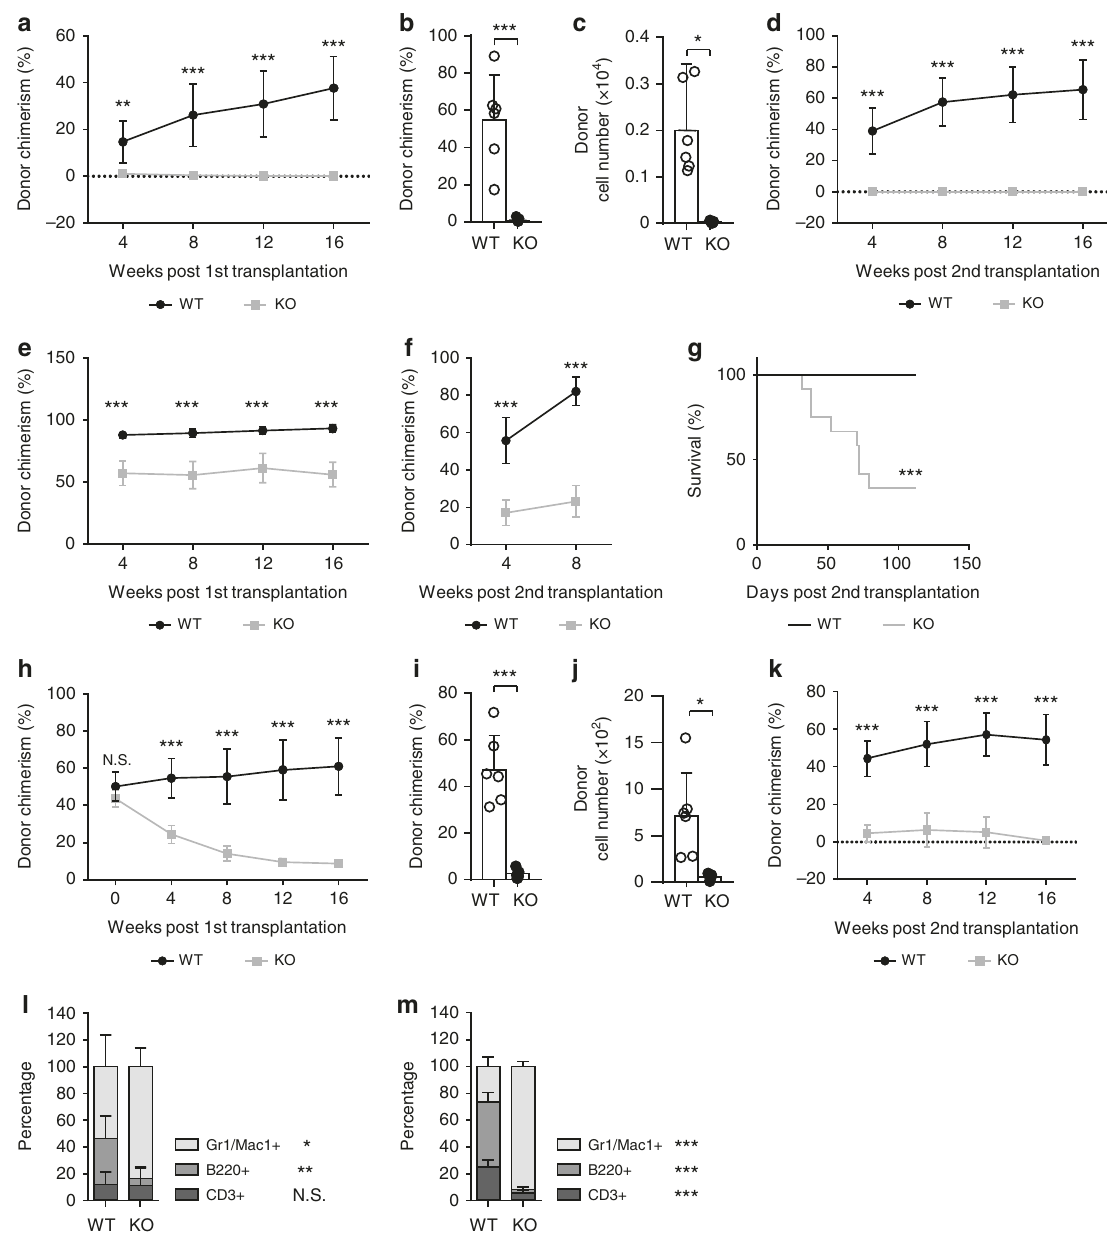
Fig. 4 Impaired self-renewal potential in med23-de fi cient HSCs. a Donor chimerism of PBMC in primary recipients transplanted with 50 HSCs (CD45.2) from WT or KO mice, along with 500,000 bone marrow cells (CD45.1) (WT, n = 6; KO, n = 7). b , c Chimerism ( b ) and absolute cell number ( c ) of donor HSCs in primary recipients at 16 weeks post-transplantation (WT, n = 6; KO, n = 5). d Donor chimerism of HSCs in secondary recipients transplanted with 2,000,000 bone morrow cells from primary recipients, described in a (WT, n = 11; KO, n = 9). e Donor chimerism of PBMC in primary recipients transplanted with 2,000,000 total bone marrow cells (CD45.2) from WT or KO mice (WT, n = 9; KO, n = 8). f Donor chimerism of PBMC in secondary recipients transplanted with 2,000,000 bone morrow cells from primary recipients, described in e . g Kaplan – Meier survival curve of secondary recipients, described in f ( n = 12). h Donor chimerism of PBMC in primary recipients transplanted with 1,000,000 bone marrow cells (CD45.2) of WT and KO mice, along with 1,000,000 bone marrow cells (CD45.1) followed by poly(I:C) administration at 4 weeks post-transplantation (WT, n = 8; KO, n = 7). i , j Chimerism ( i ) and absolute cell number ( j ) of donor HSCs in primary recipients at 16 weeks post-transplantation (WT, n = 6; KO, n = 5). k Donor chimerism of PBMC in secondary recipients transplanted with 2,000,000 bone morrow cells from primary recipients, described in h (WT, n = 8; KO, n = 9). l Percent of myeloid, B and T cells in peripheral blood of recipient mice, described in a at 16 weeks post-transplantation ( n = 5). m Percent of myeloid, B and T cells in peripheral blood of recipient mice, described in e at 16 weeks post-transplantation (WT, n = 8; KO, n = 9). The data are means ± S.D., for all panels: * p < 0.05, ** p < 0.01, *** p < 0.001 by Student ’ s t -test, N.S. no signi fi